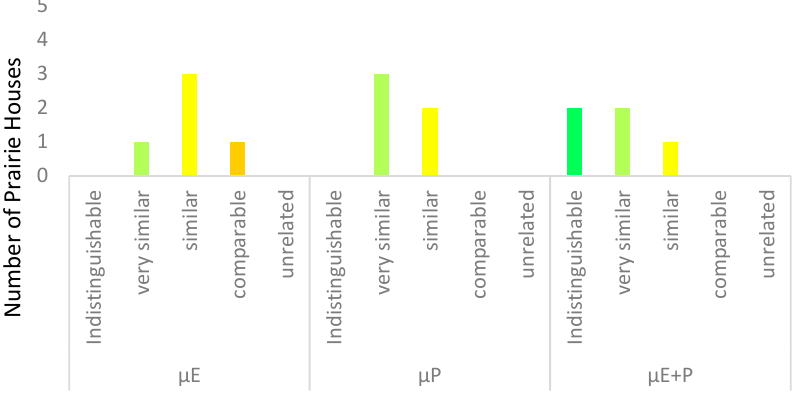
Figure 12. Qualitative comparison of Prairie houses and Fallingwater.